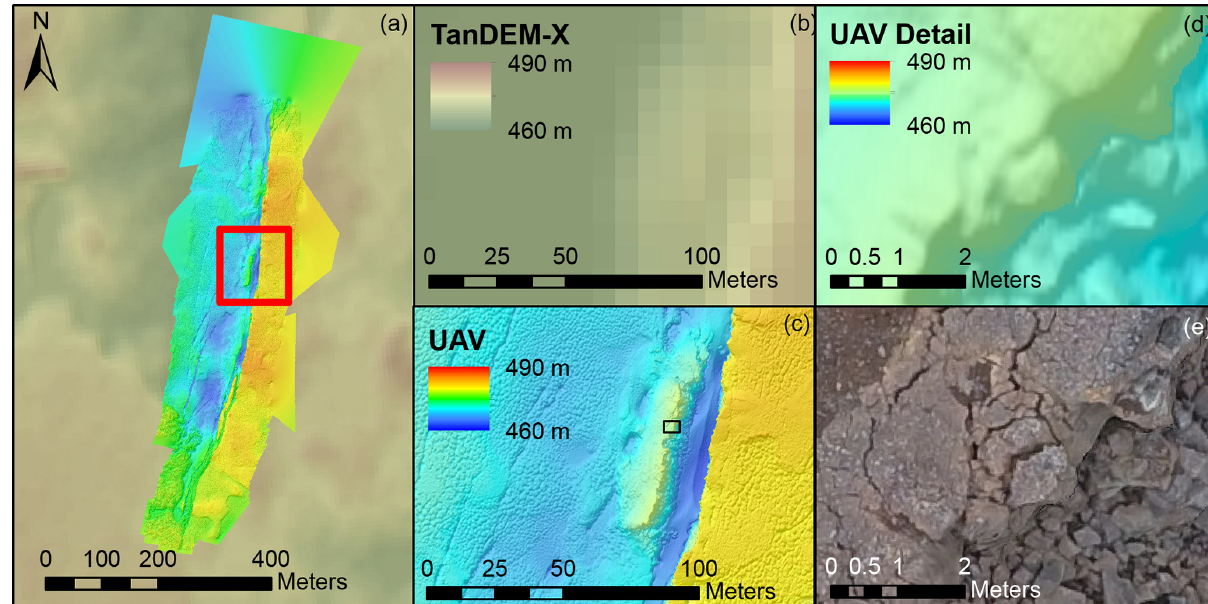
Figure 6. (a) Drone-based high-resolution DEM of fault belonging to the Krafla fissure swarm, projected on TanDEM-X WorldDEM ™ . (b) Detailed view on the TanDEM-X WorldDEM ™ tile of the area marked in panel (a) . (c) High-resolution DEM analogue to panel (b) . (d) Detailed view of area marked in panel (c) of the high-resolution DEM. (e) Orthorectified UAV-photography analogue to panel (d) . Location of the DEM: 65 ◦ 51 (cid:48) 19 (cid:48)(cid:48) N, 16 ◦ 43 (cid:48) 12 (cid:48)(cid:48) W. Projection of the DEM and orthomosaics: WGS1984 UTM